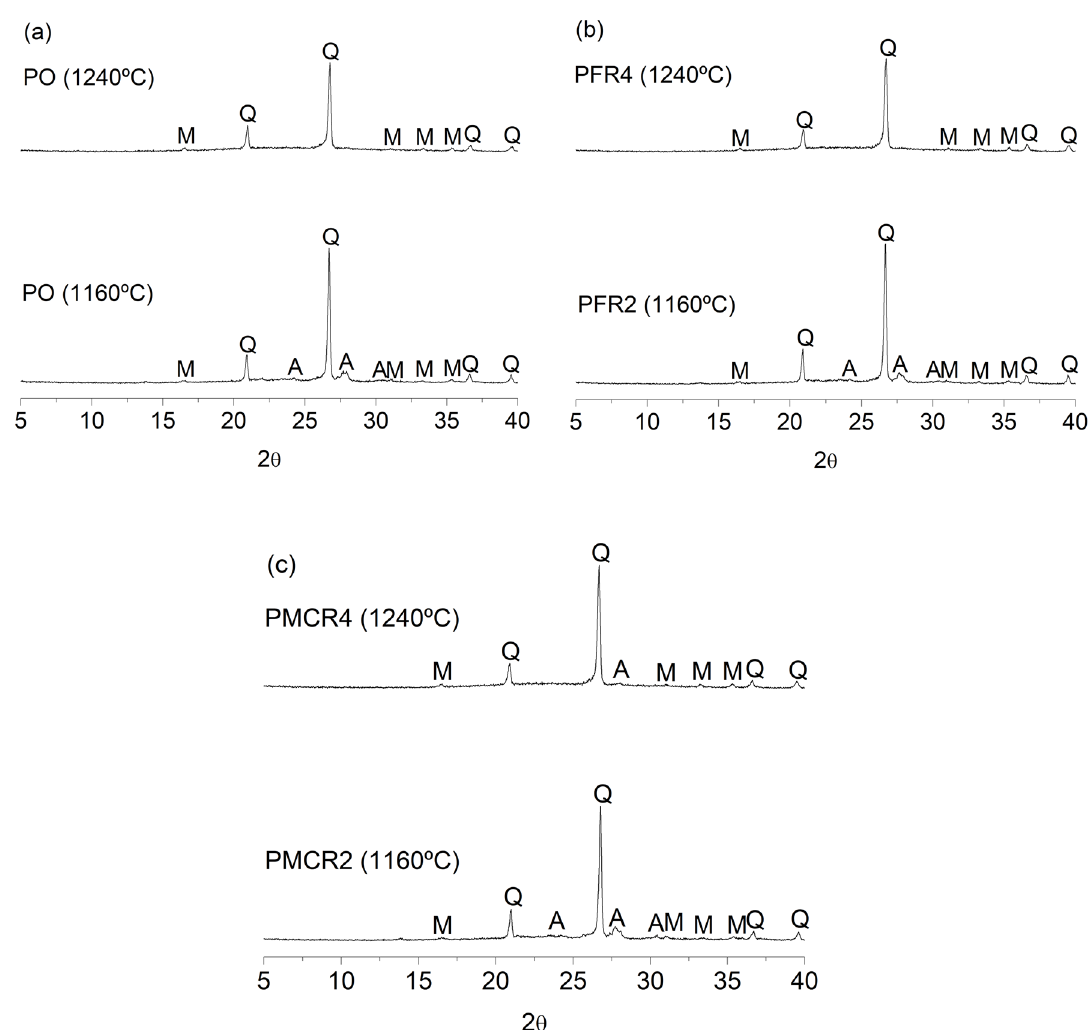
Figure 7. XRD spectra of pieces produced from: (a) ceramic mass for porcelain tile (PO); (b) composition with 9 wt.% of fine quartzite residue (PFR2, PFR4); (c) composition with 9 wt.% of milled coarse quartzite residue (PMCR2, PMCR4); sintered at 1160 and 1240ºC. A - Anorthite; M - Mullite; Q -